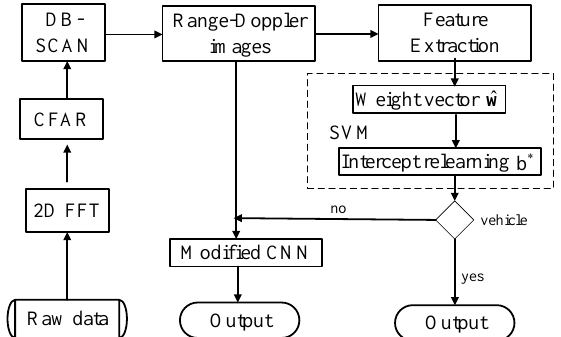
Figure 2. Flowchart of the hybrid support vector machine (SVM)-CNN classification method.